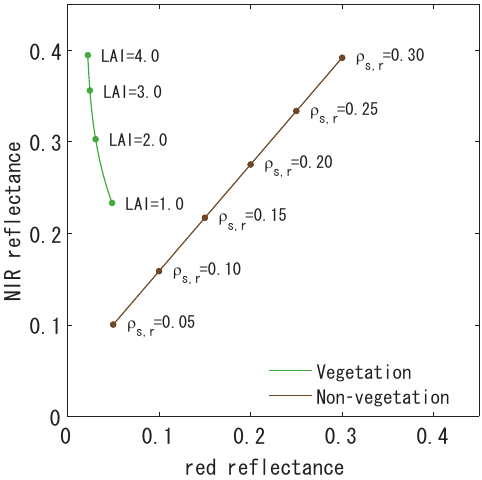
) are indicated in the s,r